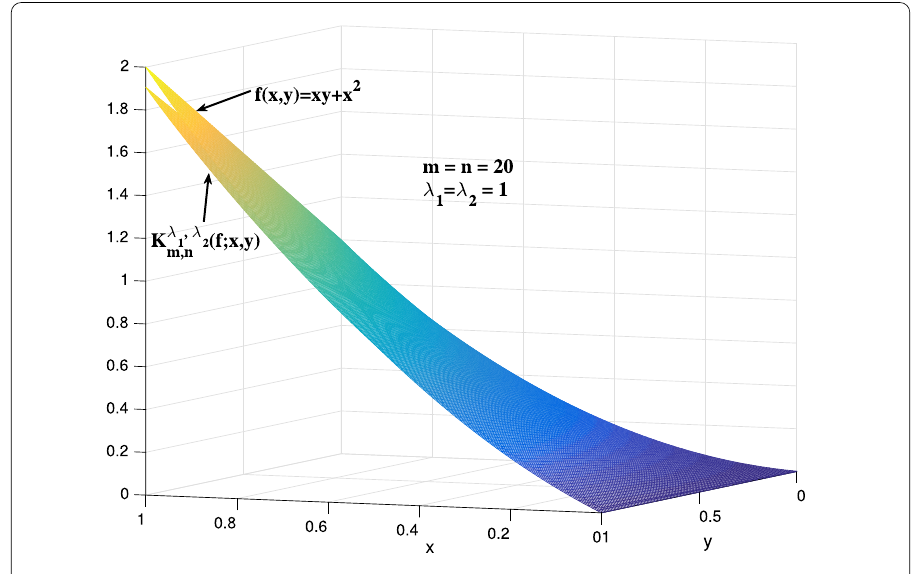
Figure 3 Graphs of K 1,1 20,20 ( f ; x , y ) and f ( x , y